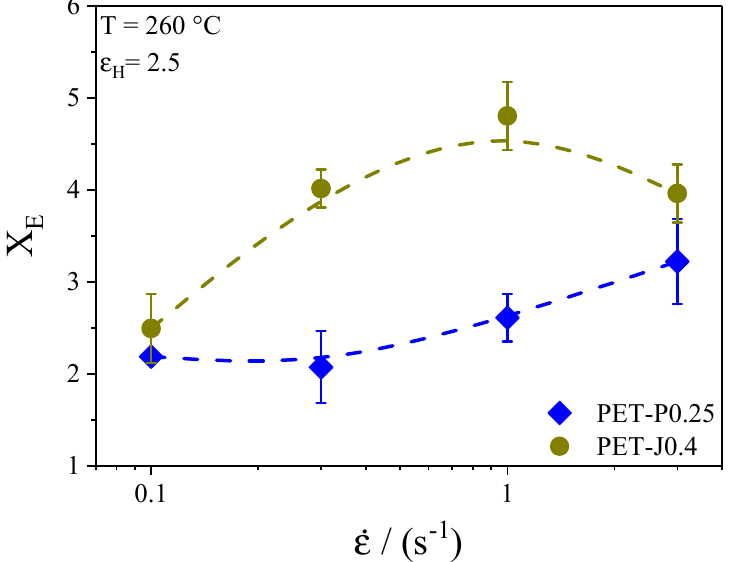
Figure 5. Strain hardening factor X E as a function of elongational rate 𝜀(cid:4662) at a Hencky strain of 2.5 for PET-J0.4 and PET-P0.25.